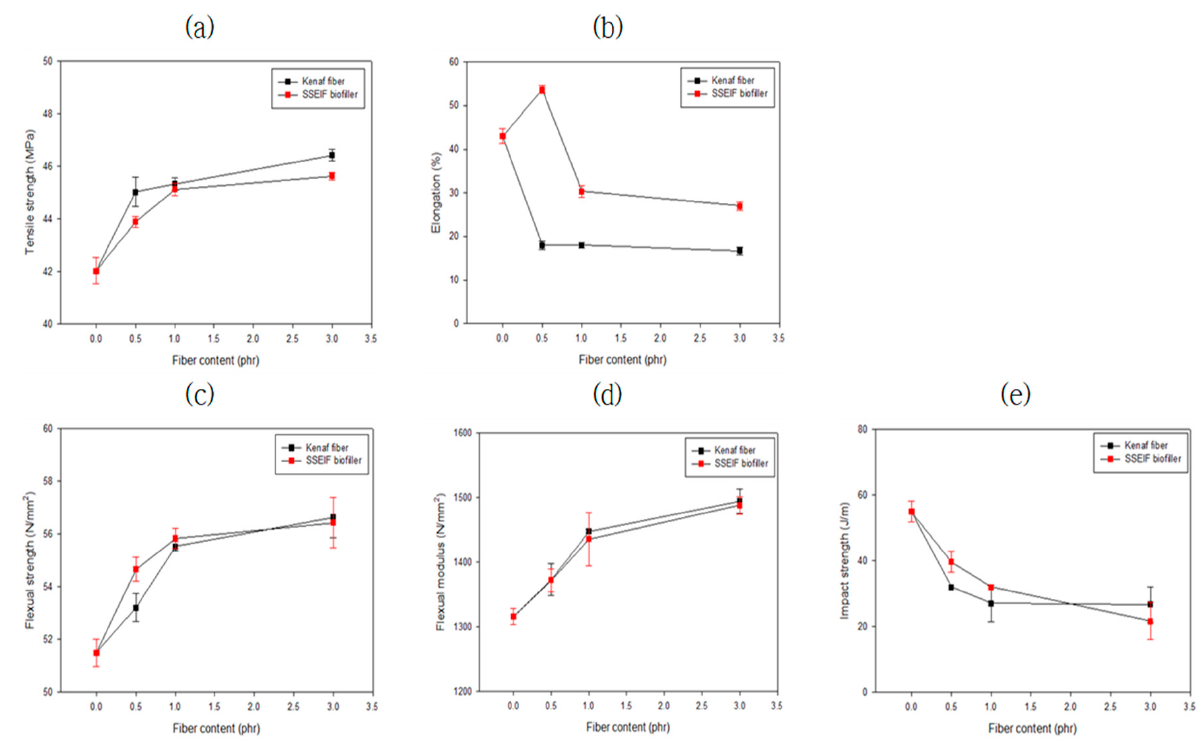
Figure 16. Mechanical strength of CAP–biofiller composites: ( a ) tensile strength @ break; ( b ) elongation; ( c ) flexural strength; ( d ) flexural modulus; and ( e ) impact strength (Izod, Norch).